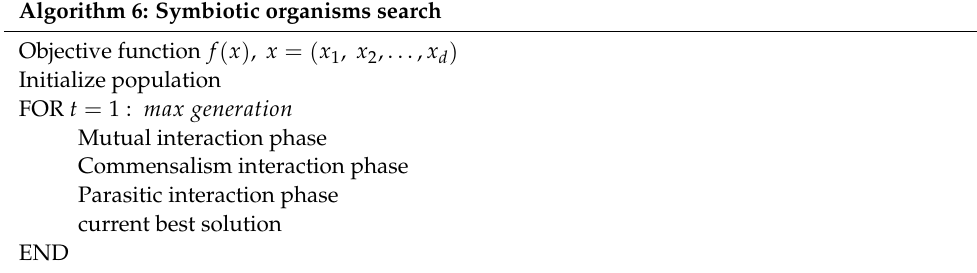
Algorithm 6: Symbiotic organisms